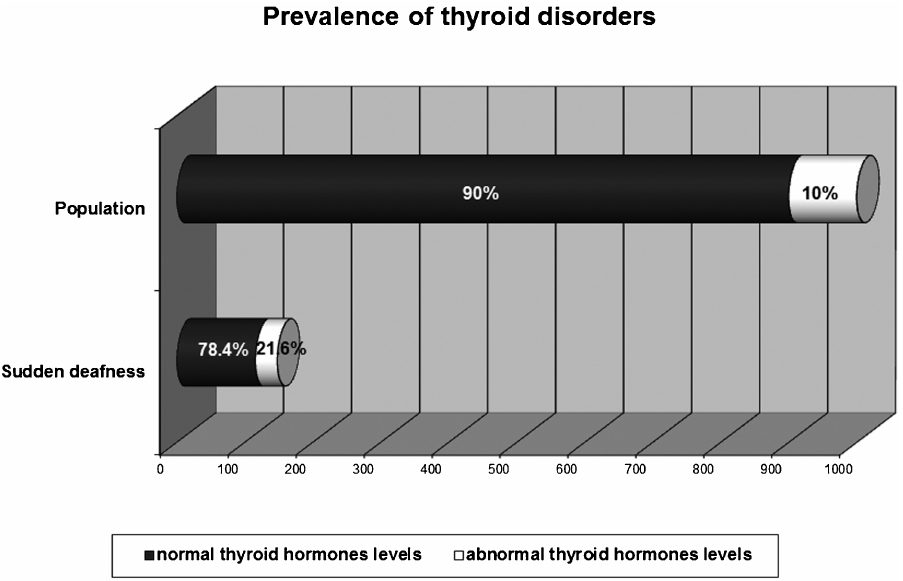
Figure 2 - Prevalence of thyroid disorders in patients with sudden deafness and in the general